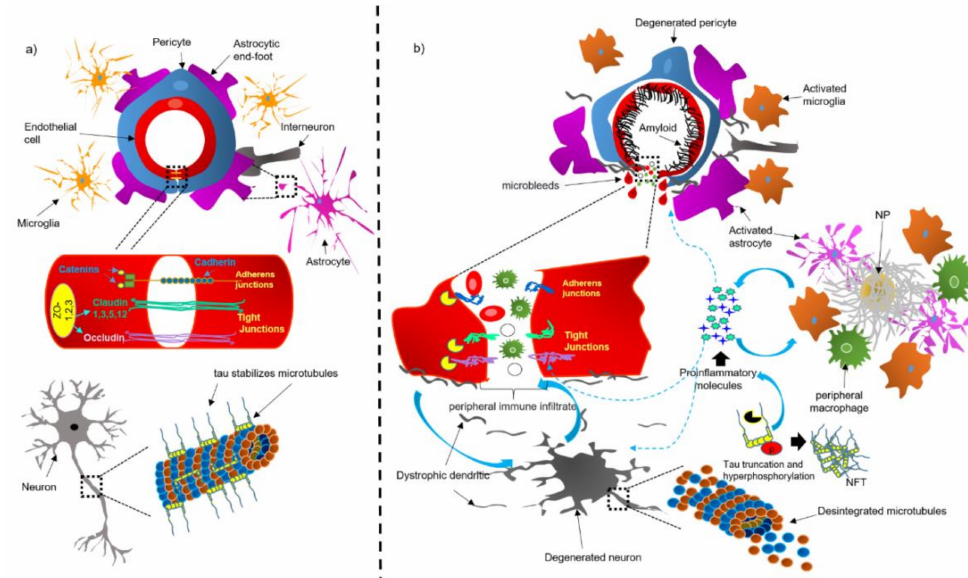
Figure 2. Schematic representation of the NVU under physiological ( a ) and pathological ( b ) condi- tions. Abbreviations: NFT, neurofibrillary tangle; NP, neuritic